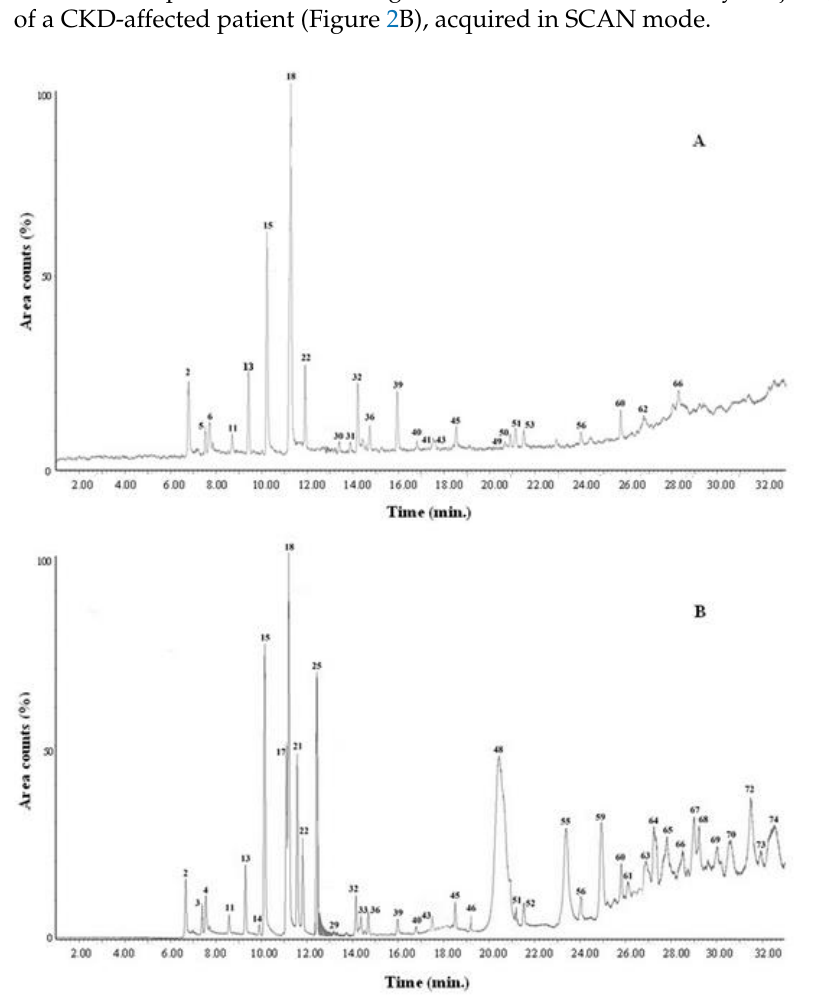
Figure 2. Breath chromatographic profile (SCAN mode) of a healthy subject ( A ) and of a CKD-affected patient prior to undergoing a kidney transplant ( B ). Overall, seventy- four VOCs were detected (S/N ≥ 3), while sixty-seven were identi- fied and these are reported in Table 6.